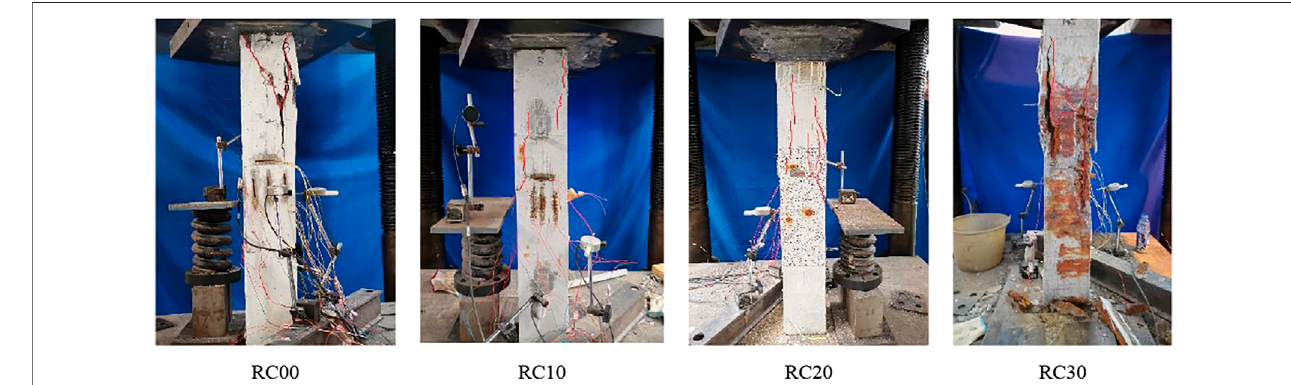
FIGURE 5 | Failure mode of the unreinforced specimen.